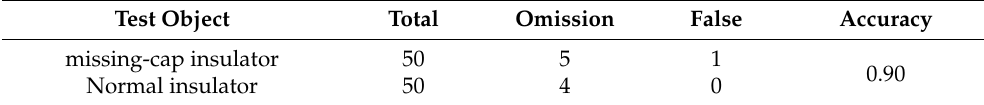
Table 3. Compared with ensemble classifier or multi feature classifier. Test Object